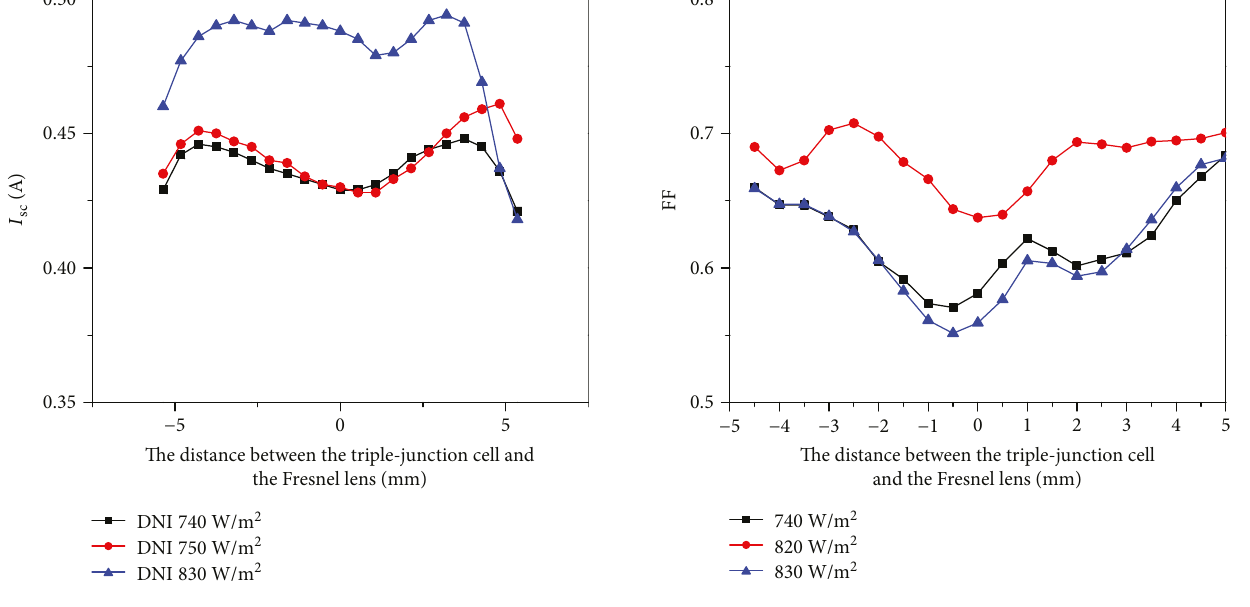
Figure 12: The short circuit current of the triple-junction cell along with the change of optical axis positions.